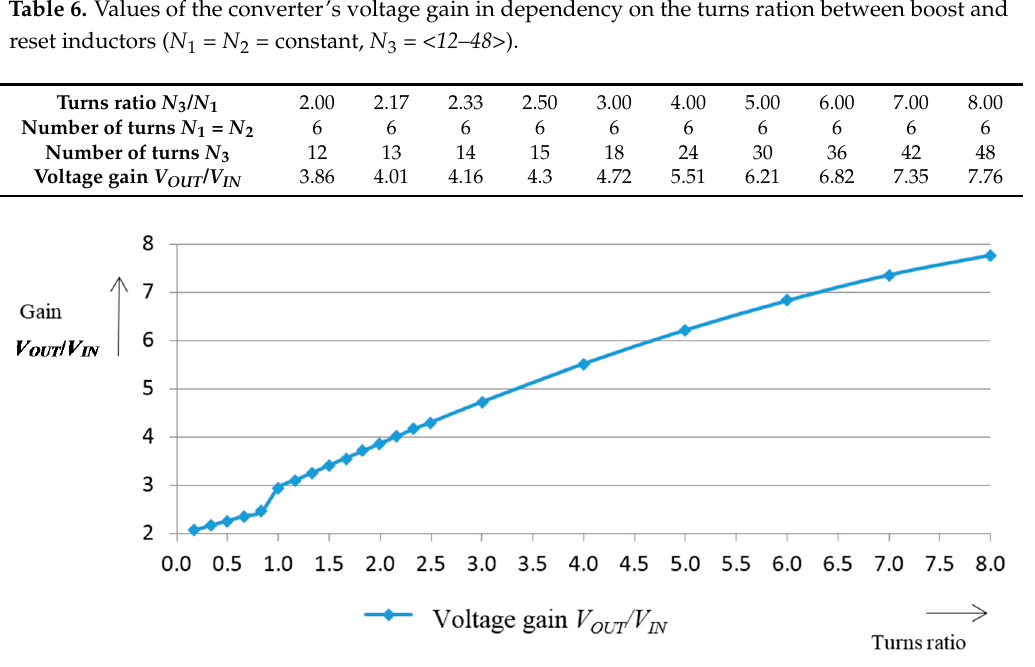
Table 6. Values of the converter’s voltage gain in dependency on the turns ration between boost and